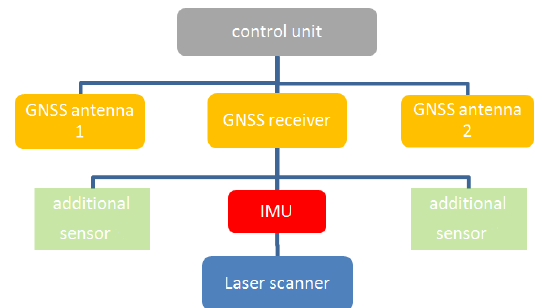
Figure 6. Sensor platform